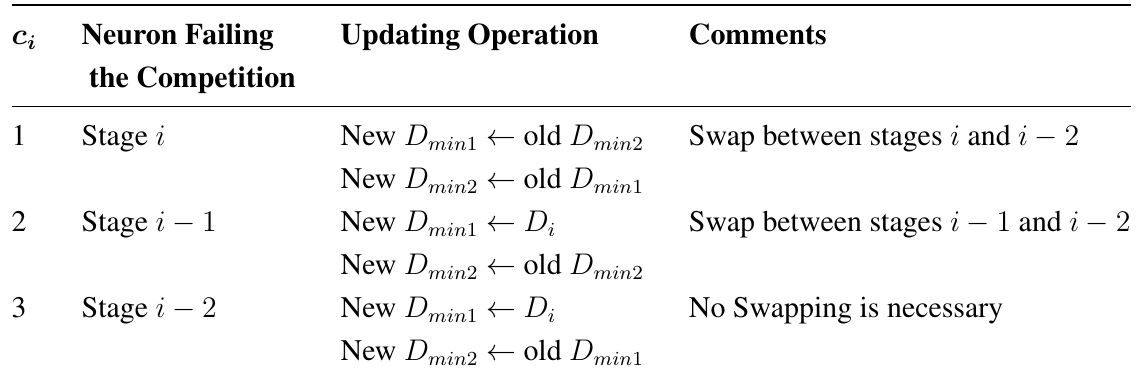
; :::; D of the distribution unit at stage i for min 1 min k